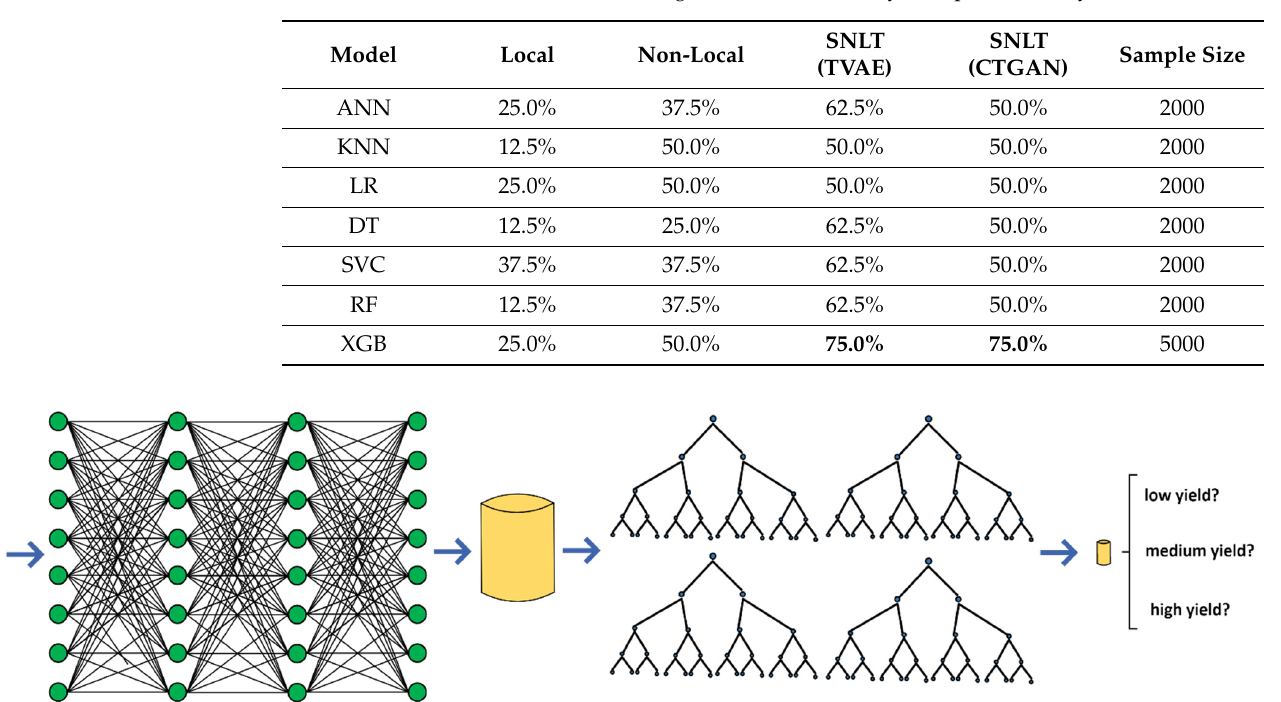
Table 8. Train SD, test Highmore, SD only one variety per year and 8 target samples: best accuracies (bold) from Highmore local training, non-local training (rest of SD), and SNLT with CTGAN and TVAE (rest of SD), each for three class labels (high, medium, and low yield), plus size of synthesized dataset.